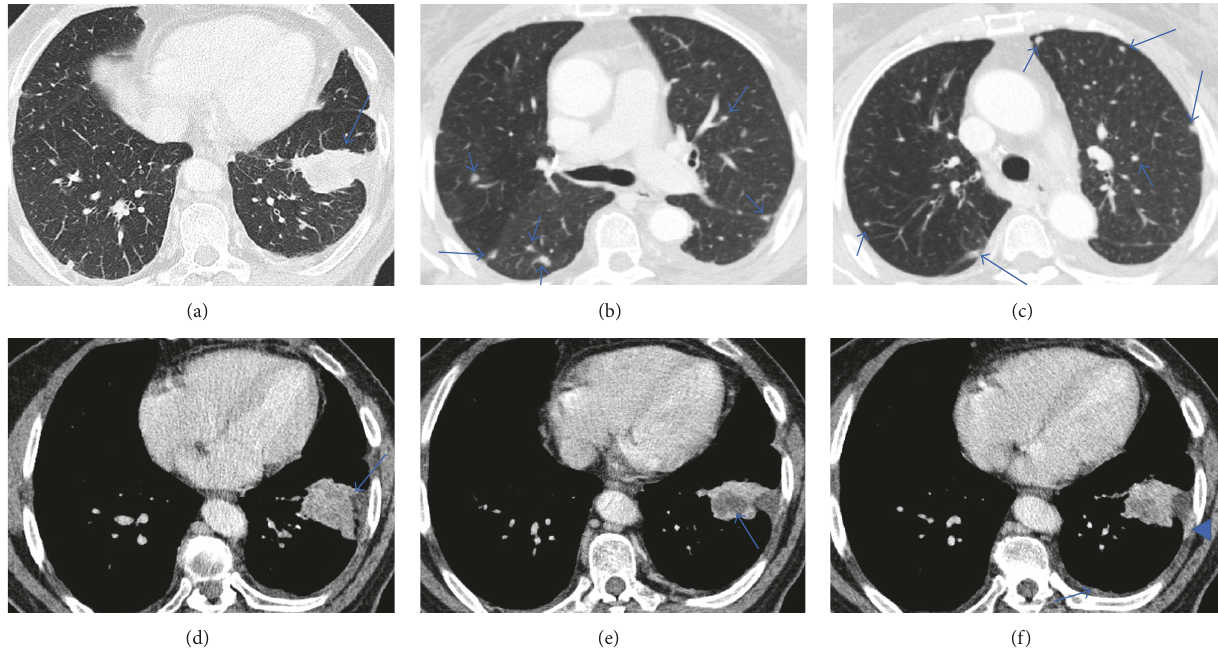
Figure 8: Chest CT. Multislice chest CT-images on lung window (a, b, and c) showed a lung mass with irregular borders (a); they also showed multiple small, round, and noncalcified pulmonary nodular opacities, scattered in both lungs (b and c). On mediastinal window (d, e, and f) it is possible to better identify the pleural invasion (d) and the necrotic areas in lesion (e), retrospectively, and valorization is hard when the exam was performed, and we can recognize areas of enhancement in the left pleura, more nodular (arrow) or linear (arrowhead) (f).